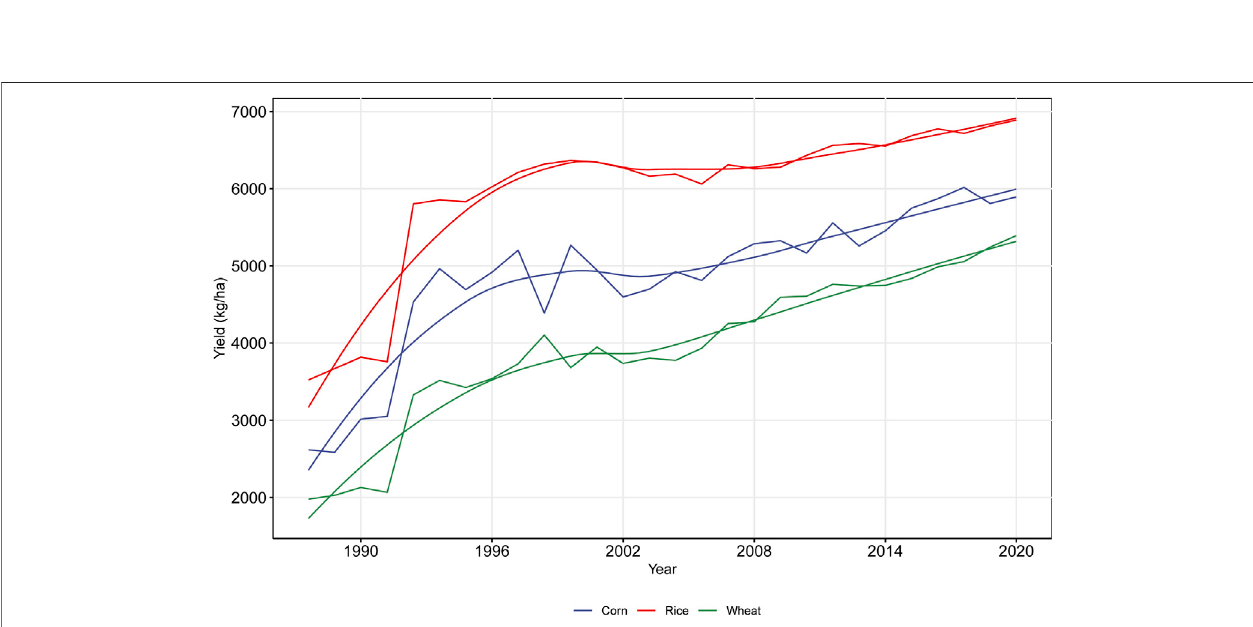
FIGURE 4 | Changes in the yield of rice, wheat, and maize in China from 1988 to 2020. The smooth lines in each panel represent loss trends.